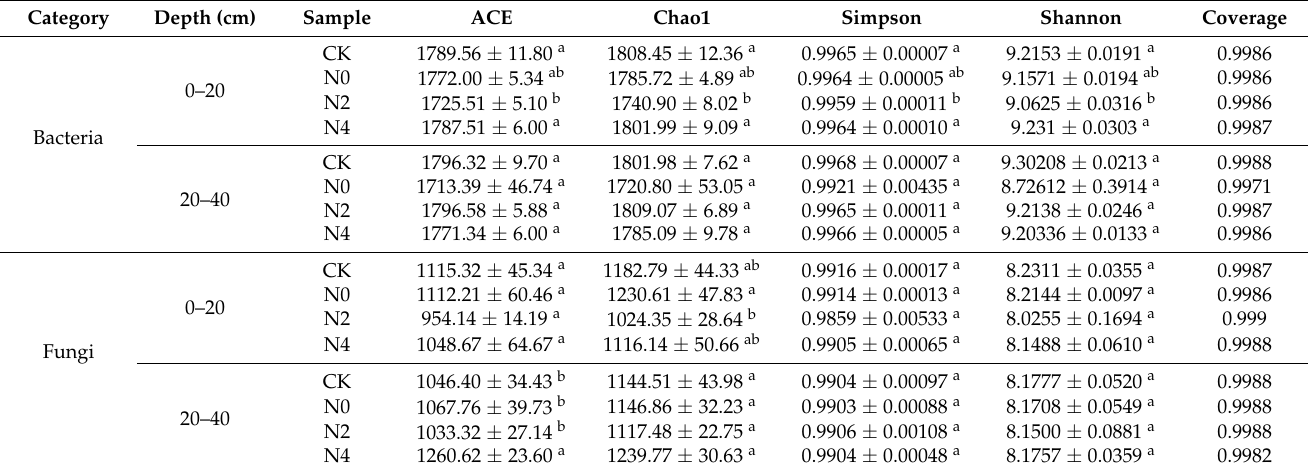
Table 1. Alpha diversity analysis of different